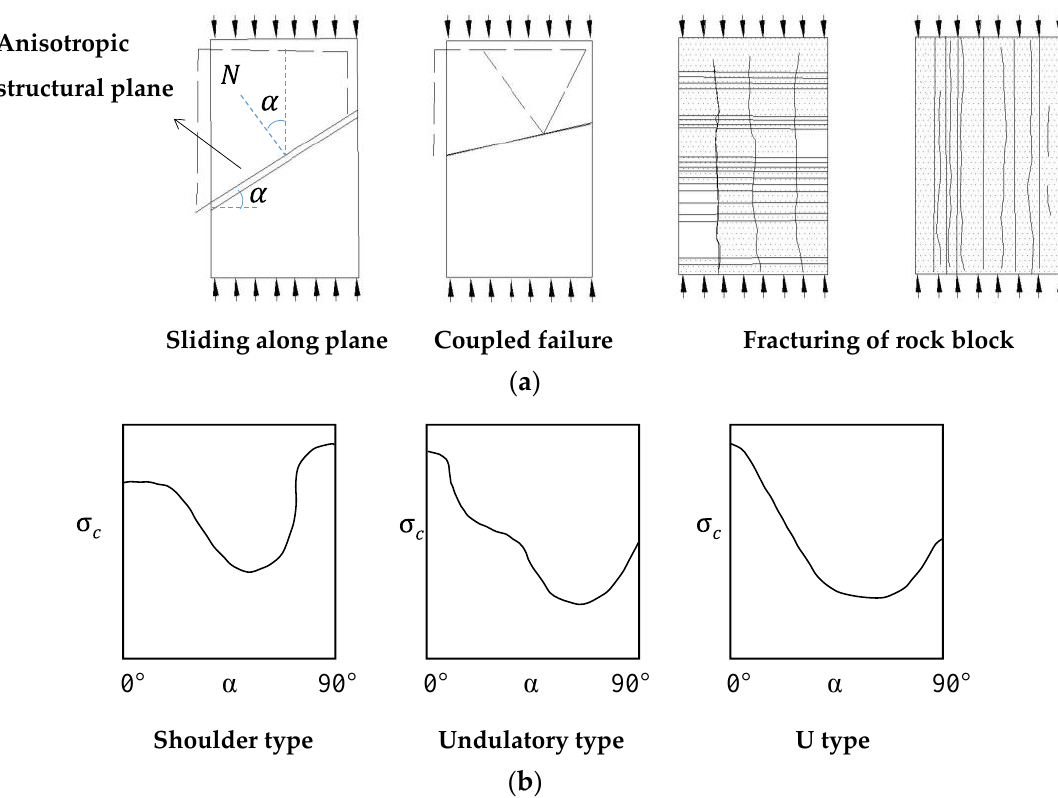
Figure 1. The direction dominant mechanical behavior of anisotropic rock mass. ( a ) The failure types anisotropy; ( b ) the strength anisotropy (modified based on [35]).